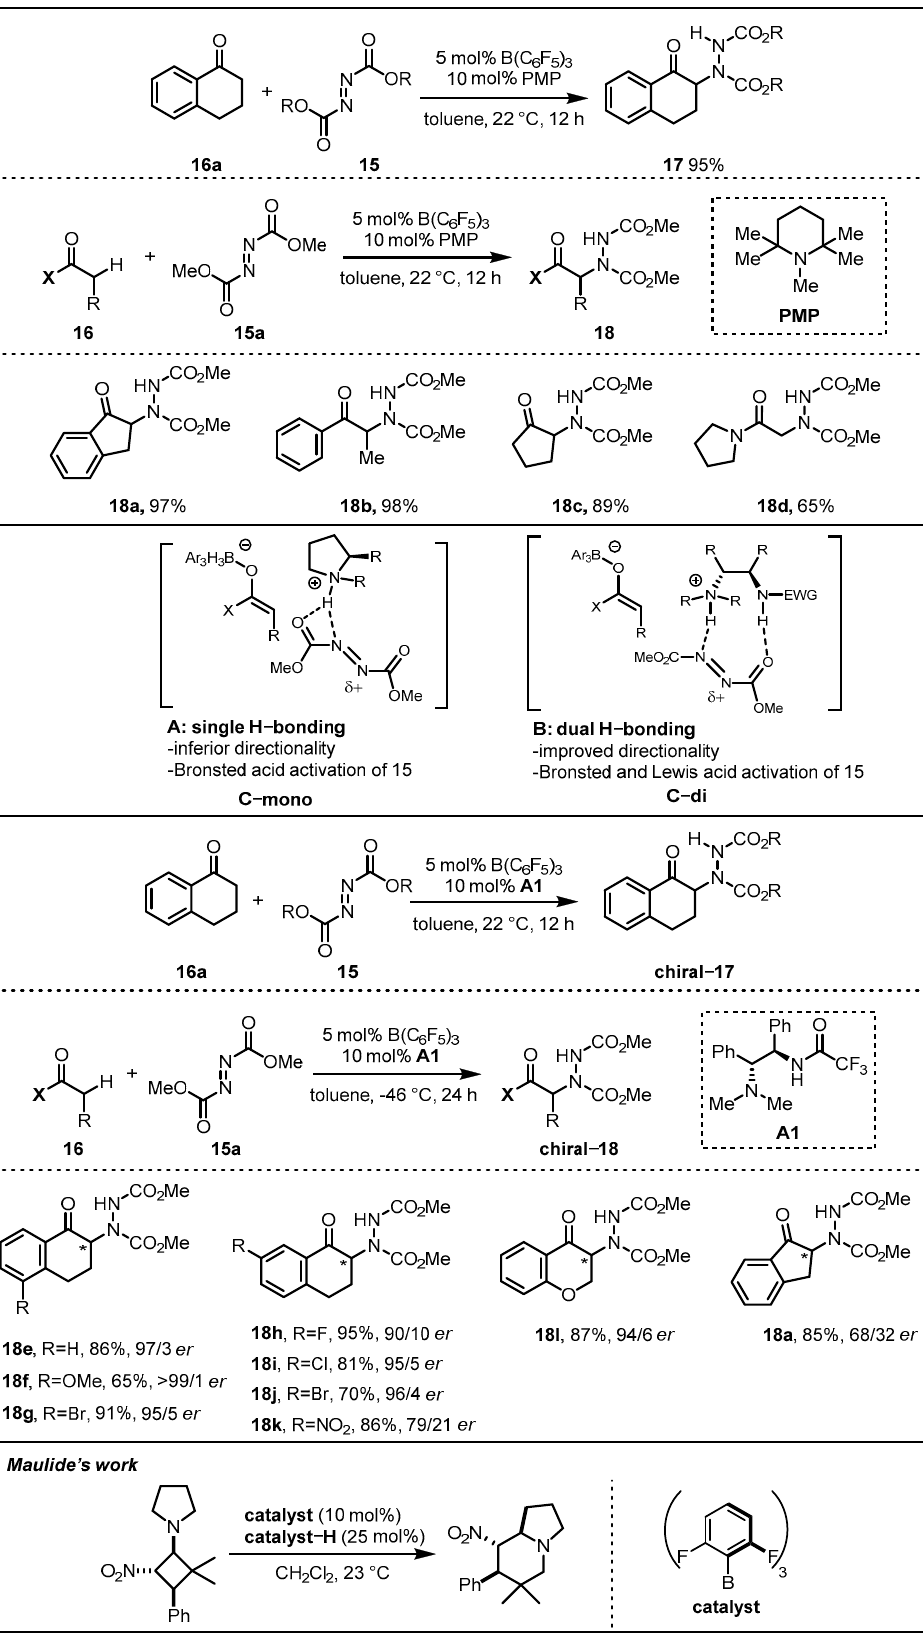
Figure 7. B(C 6 F 5 ) 3 /amine-catalyzed direct α -amination reactions.